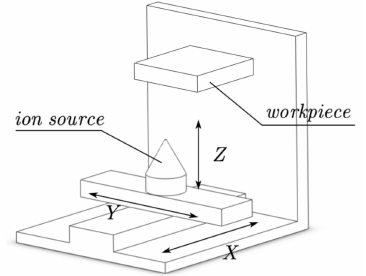
Figure 1. Three-axis IBF machine